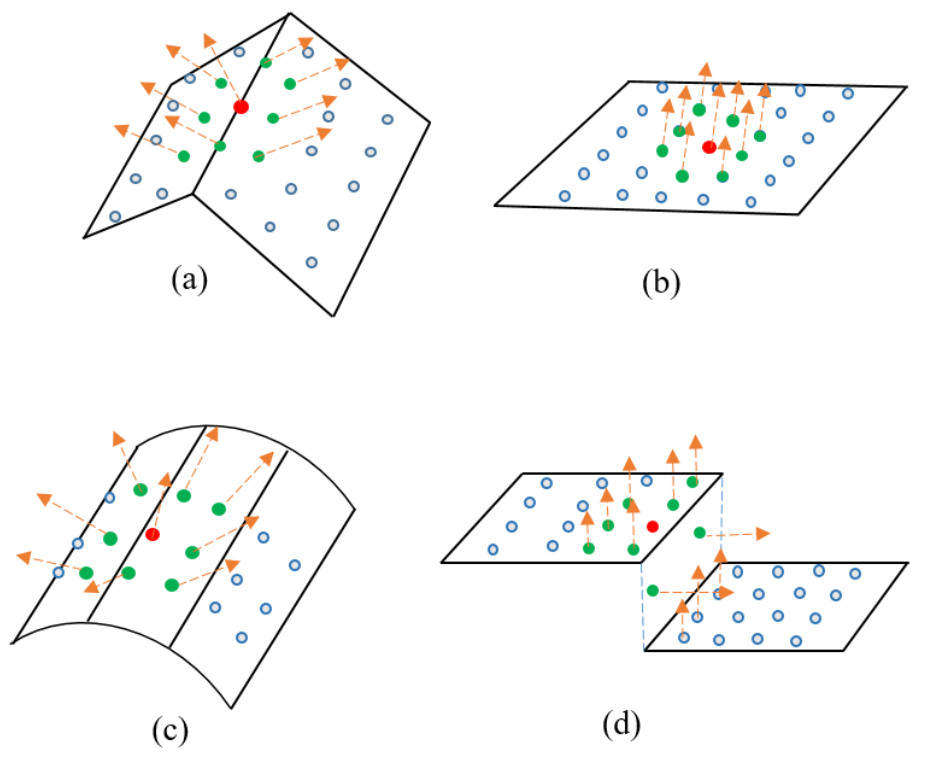
Figure 4. Cases to decide fold points P i (red dots). Their adjacent points are shown by green dots. Arrows indicate normal directions. ( a ) Gable roof, ( b ) planar surface, ( c ) curved surface, and ( d ) step edge between